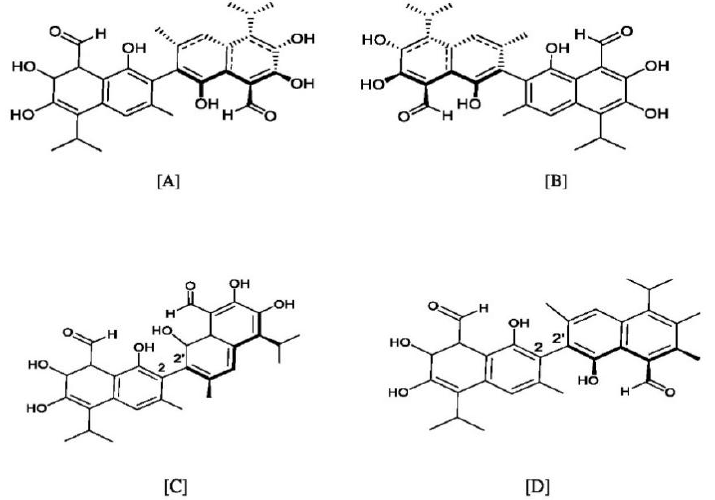
Table 1. Plant species containing gossypol [9].